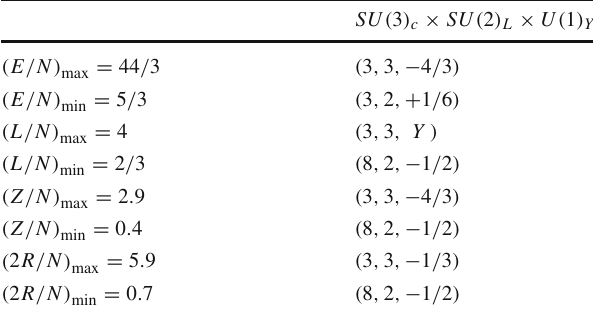
Table 1 Maximum and minimum values of the model-dependent coef- ficients for the benchmark KSVZ models with only one exotic fermion representation depicted in Fig.